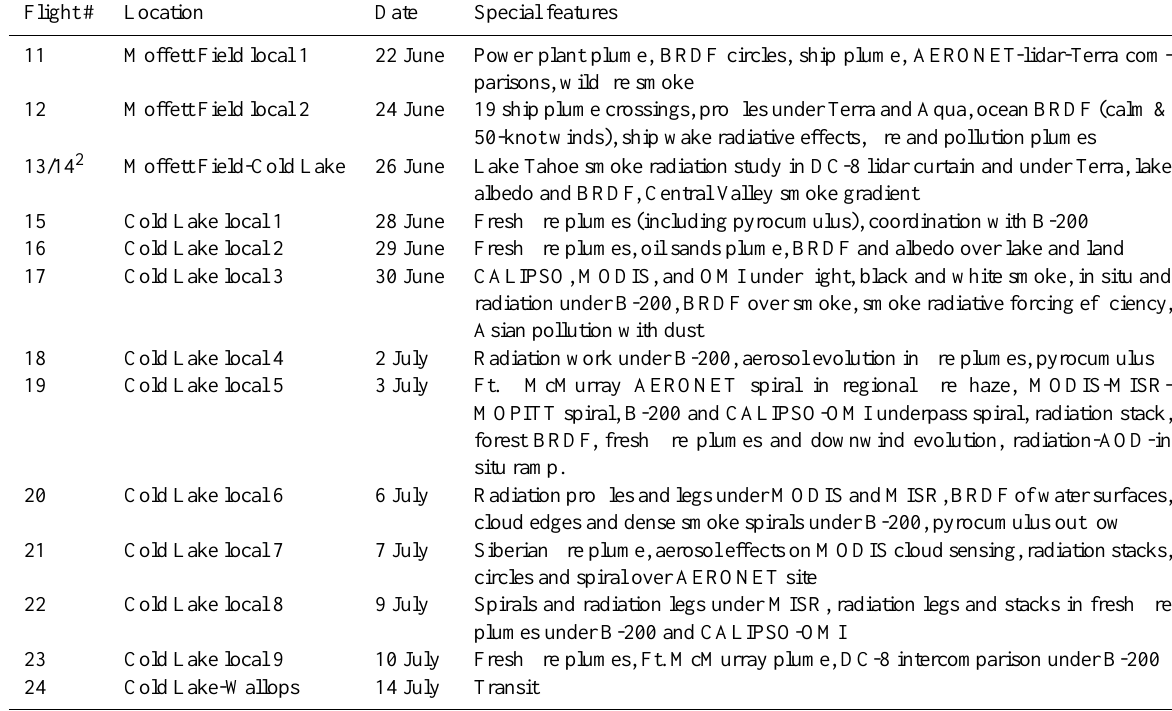
Table 5b. P-3 flights during the ARCTAS-B summer deployment 1 .